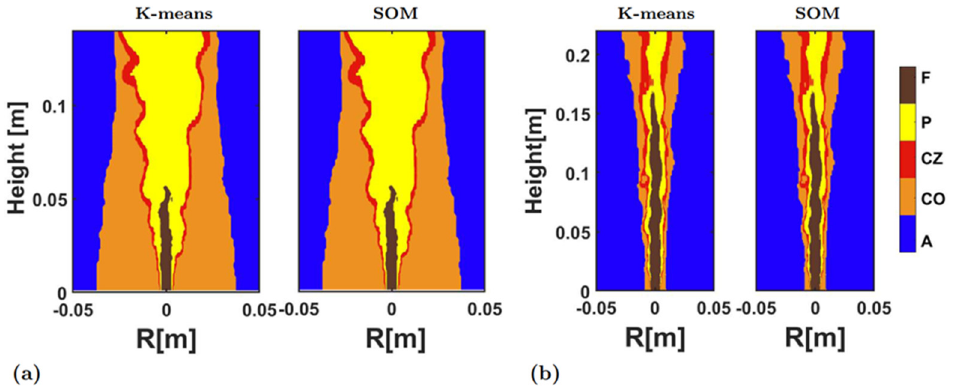
Figure 5. Distributions of two cases divided by two clustering algorithms ( a ) HM1; ( b ) Sandia Flame D.